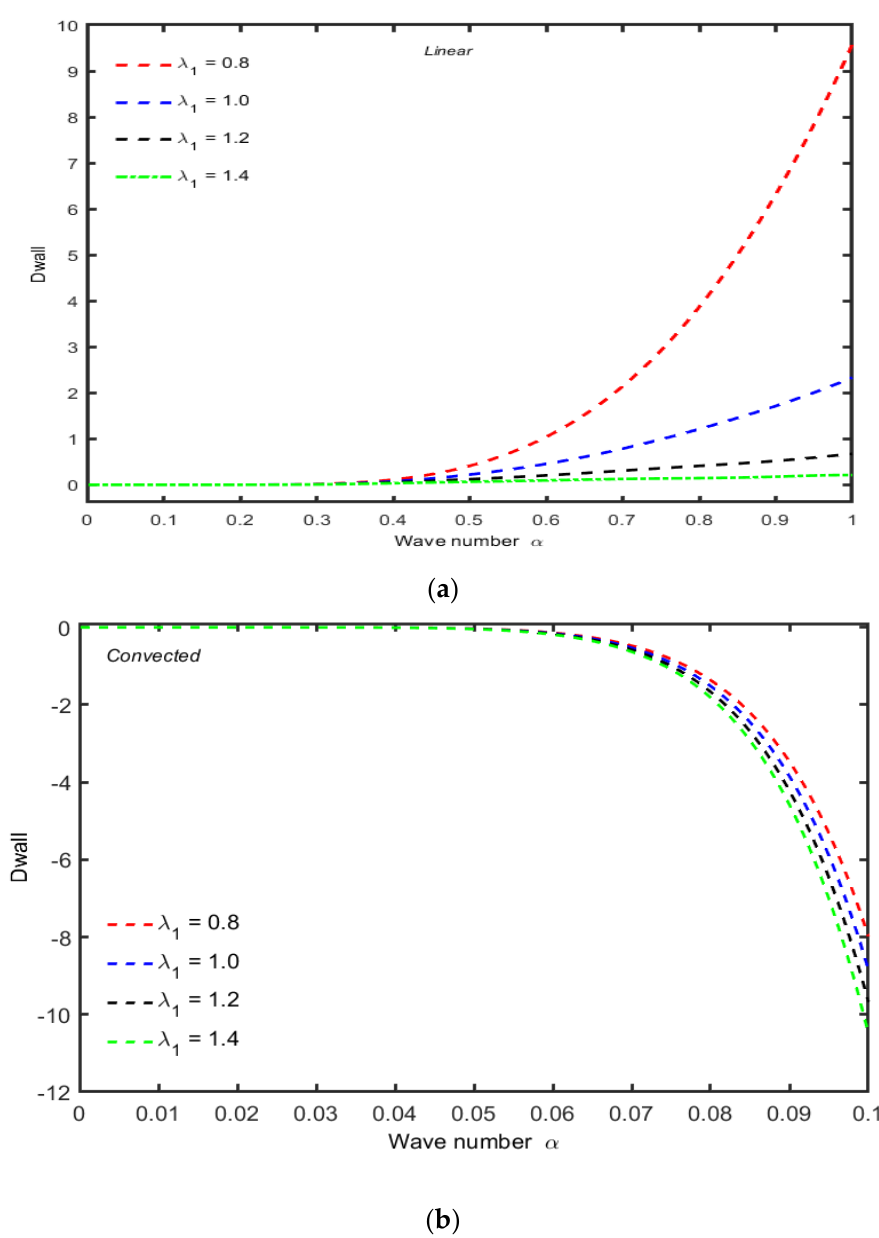
Figure 4. ( a ) Variation of D wall against the wave number α for several values of λ 1 when other parameters are R = 50, χ = 0.001. ( b ) Variation of D wall against α with λ 1 R = 50, χ = 0.001. The impacts of compressibility on the D wall = U 20 ( 1 ) are highlighted in Figure 5a,b. It is observed that for any value of α , the velocity at the boundary is increasing the compress- ibility of the fluid in case of a linear Maxwell model; also in this case, there is no indication of reverse flow. The variation of D wall with χ is depicted in Figure 5b. It is observed that the variation of D wall is negative for all values of χ and keeps on decreasing as χ increases—in this case, at the vicinity of the